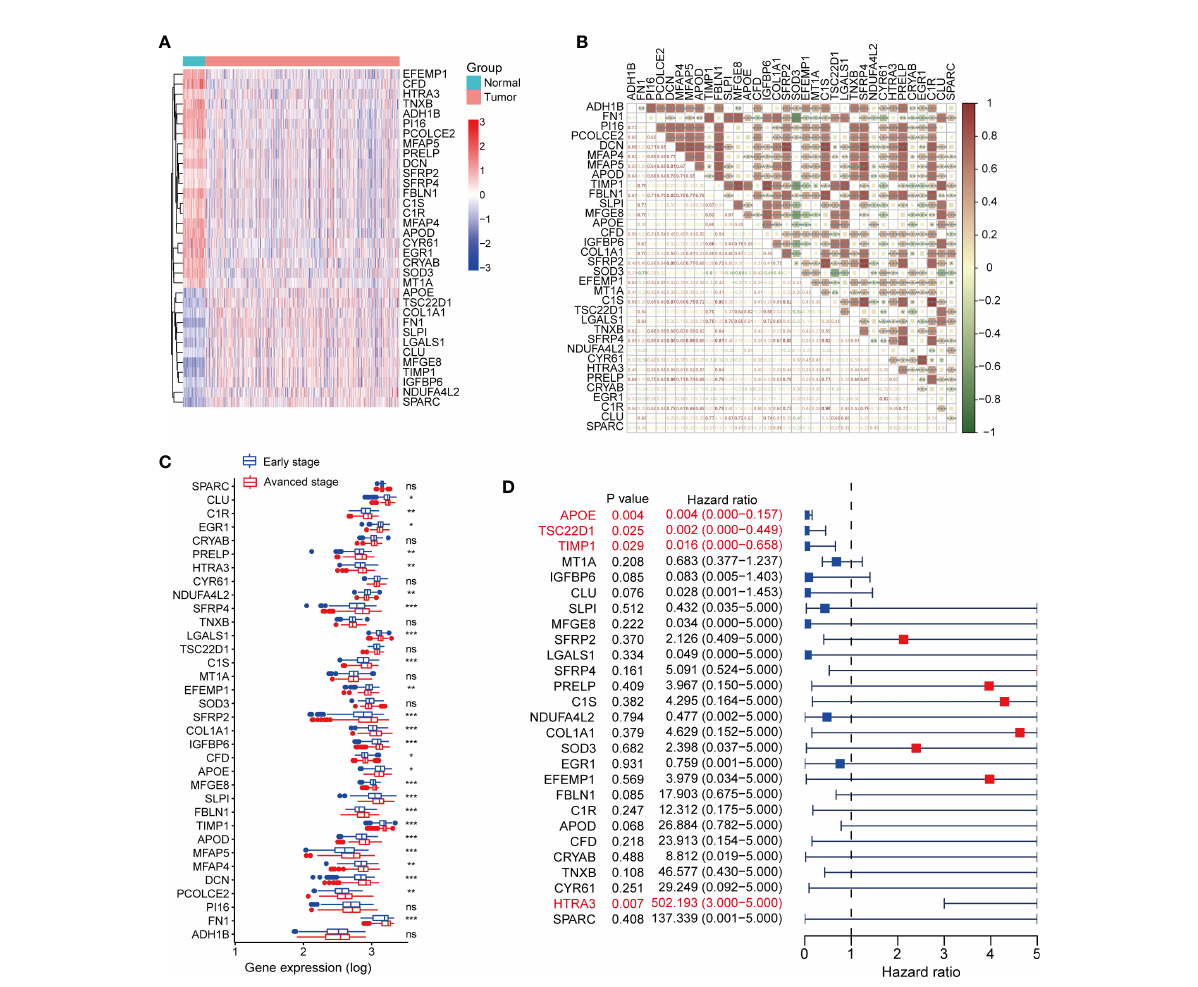
FIGURE 3 Expression pro fi les of fi broblast related genes in TCGA-THCA dataset. (A) The expression heatmap of DEFRGs between normal and tumor thyroid cancer. (B) The correlation between DEFRGs. (C) Comparing the expression of DEFRGs in early stage and advanced stage of thyroid cancer. (D) Univariate Cox regression analysis the prognostic values of DEFRGs. *P < 0.05; **P < 0.01; ***P <